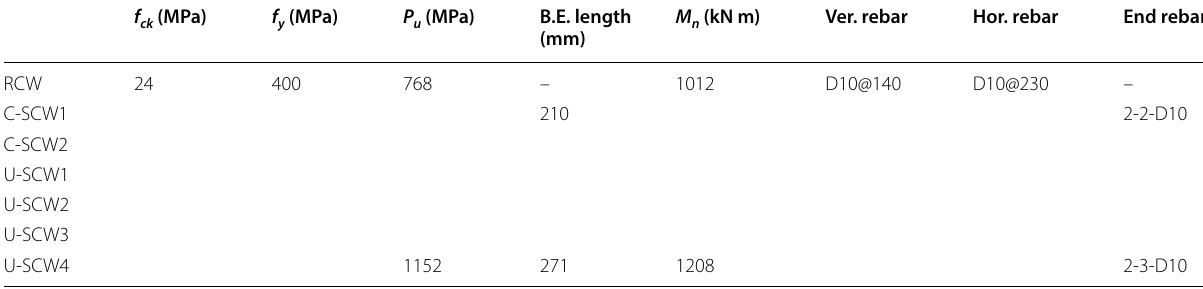
Table 3 Specimen